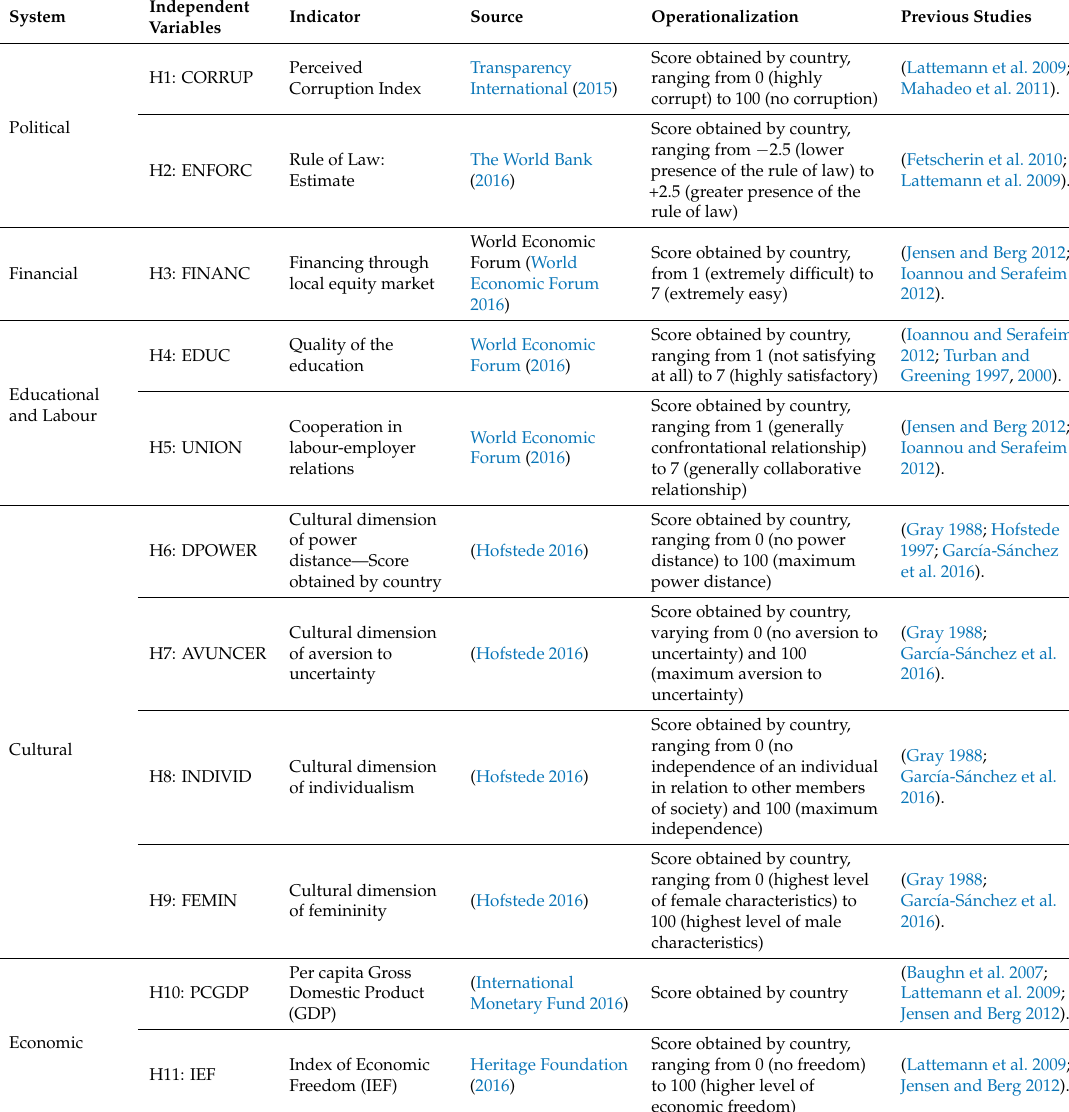
Table 2. Description of the studied